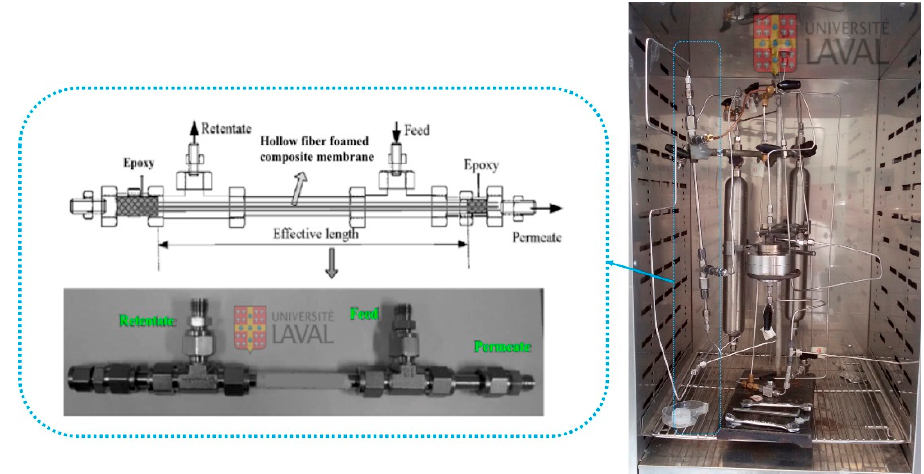
Figure 2. Schematic representation of the ( right ) permeation set-up with the ( left ) hollow fiber membrane module set-up.